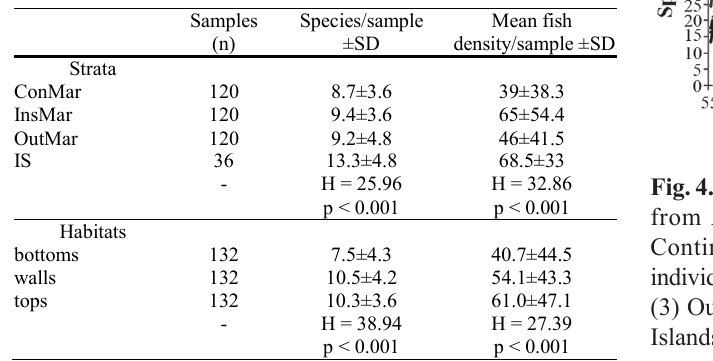
Table 2. Number of species and fish density per sample for each stratum and habitat. ConMar = Continental Margin of the São Sebastião Channel; InsMar = Insular Margin of the São Sebastião Channel; OutMar = Outer Margin of São Sebastião Island; IS = islands (Alcatrazes, Búzios and Vitória). Kruskal-Wallis one-way analysis of variance was used to test for significant differences among strata and habitats.